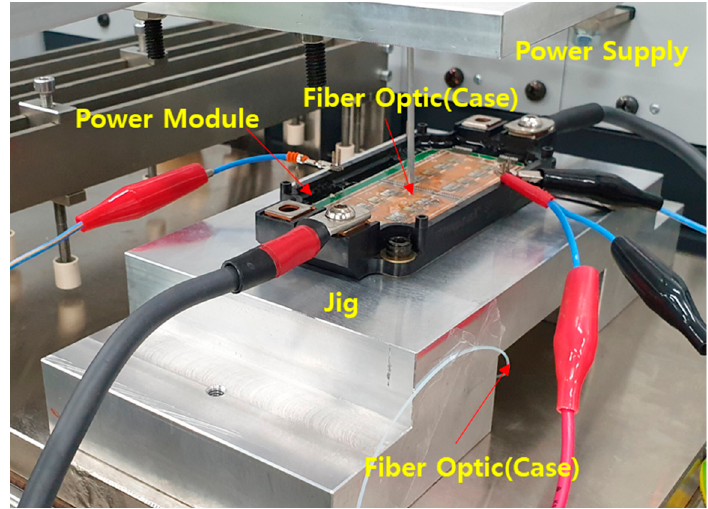
Figure 7. Experimental setup for the conventional method.